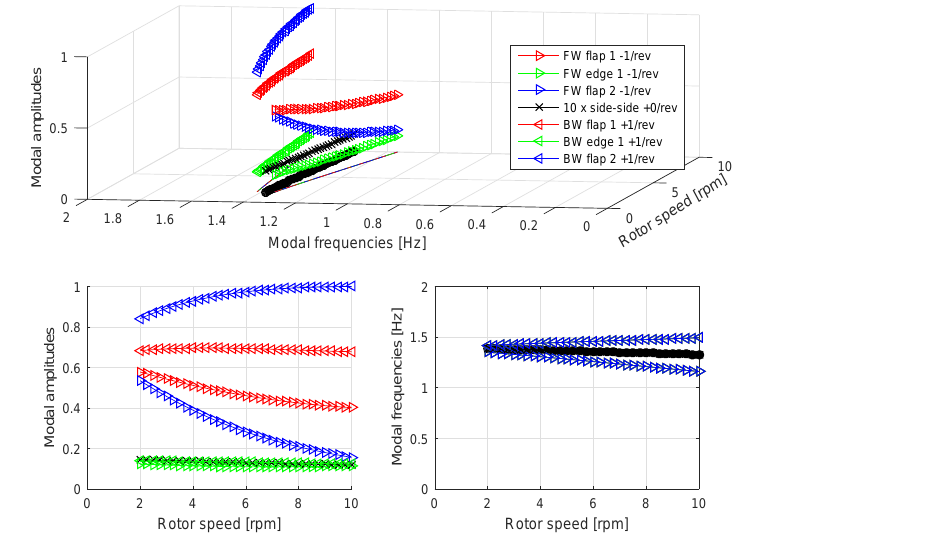
Figure 12. Harmonic modal components for the three-bladed turbine mode dominated by backward whirling (BW) of the rotor in the second flapwise DOF. Plot layout as in Fig.